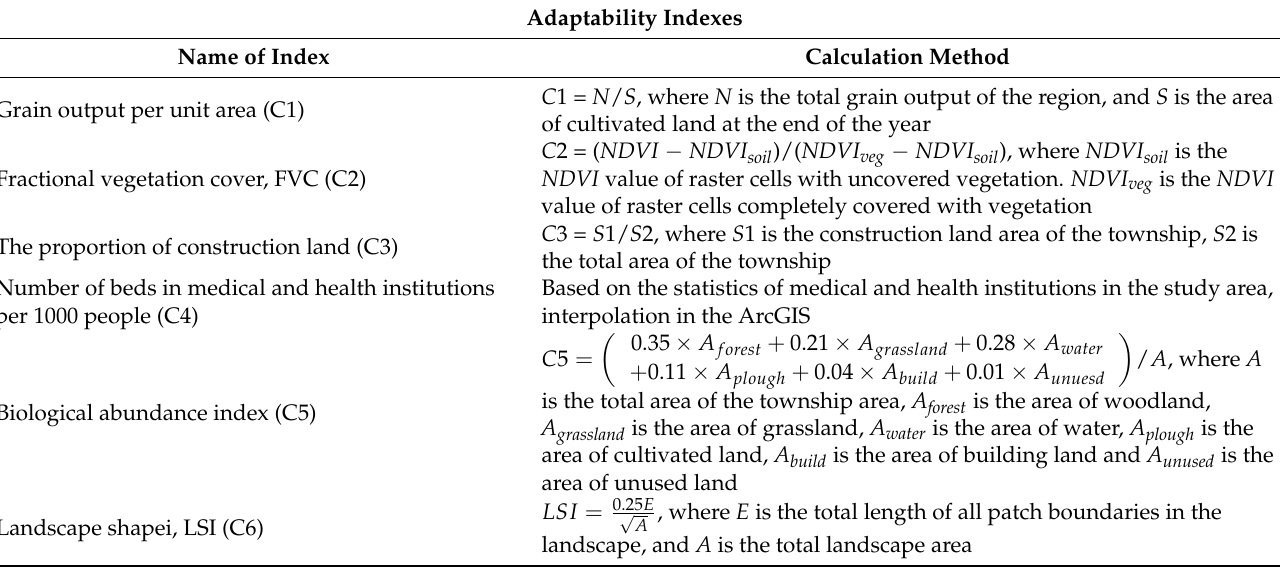
Table 4. Calculation method of adaptability